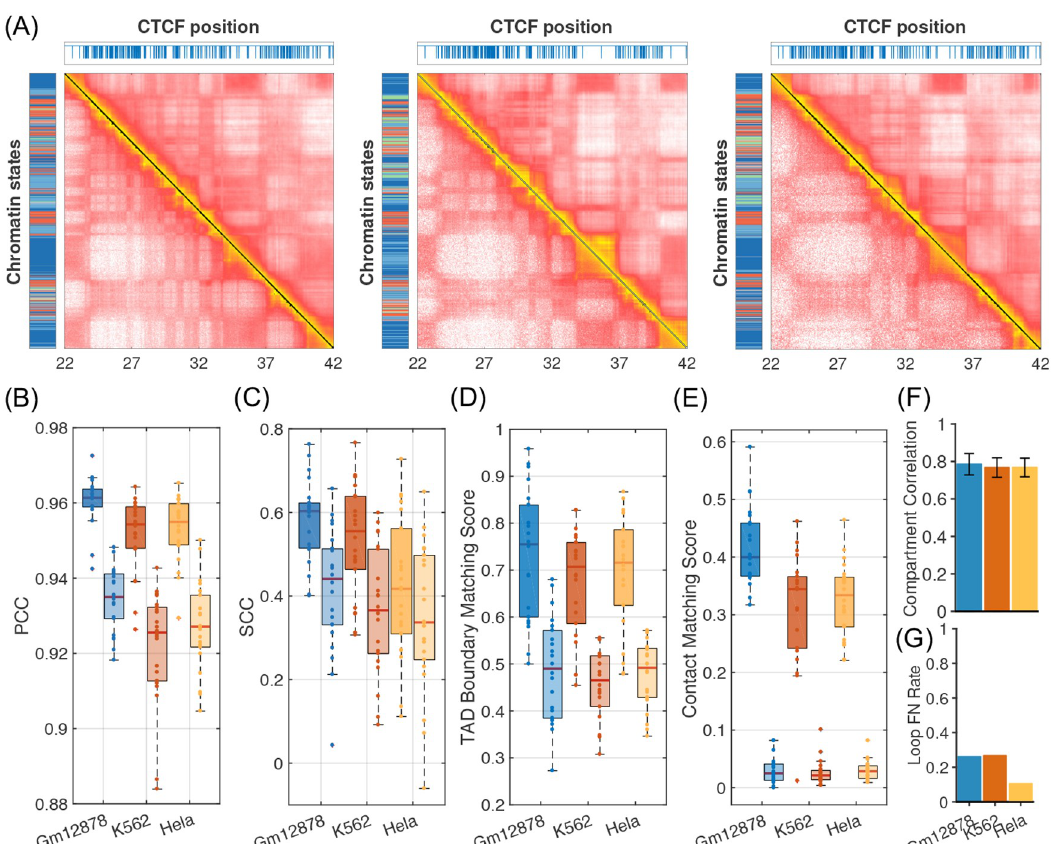
Fig 3. Transferability of the computational model across chromosomes and cell types. (A) Comparison between simulated ( Top right ) and experimental ( Bottom left ) contact maps for chromosome 2 from GM12878 ( Left ), K562 ( Middle ), and Hela cells ( Right ). (B-E) Quality of computational predictions for all chromosomes from the three cell types measured by Pearson (PCC) and stratum- adjusted correlation coefficients (SCC) between simulated and experimental contact maps (B,C), matching score for TAD boundaries detected from insulation profiles (D), and matching score for the top 1000 significant contacts (E). Each data point represents one chromosome. Data shown as light colors in (B,C) correspond to PCC/SCC between simulated and IMR90 experimental contact maps, while those in (D,E) correspond to matching scores between experimental and control data. The boxes represent the 25% and 75% quantities of the matching score distribution, and the thick line inside each box corresponds to the median value. Whiskers indicate the last values that fall within 1.5 times the interquartile range. (F) Average correlation coefficients between the top five eigenvectors for the logarithm of contact matrices for all the three cell types. Error bars correspond to standard deviations of the results for all chromosomes. (G) False negative rates for predicting chromatin loops identified in Hi-C data with convergent CTCT binding sites in different cell